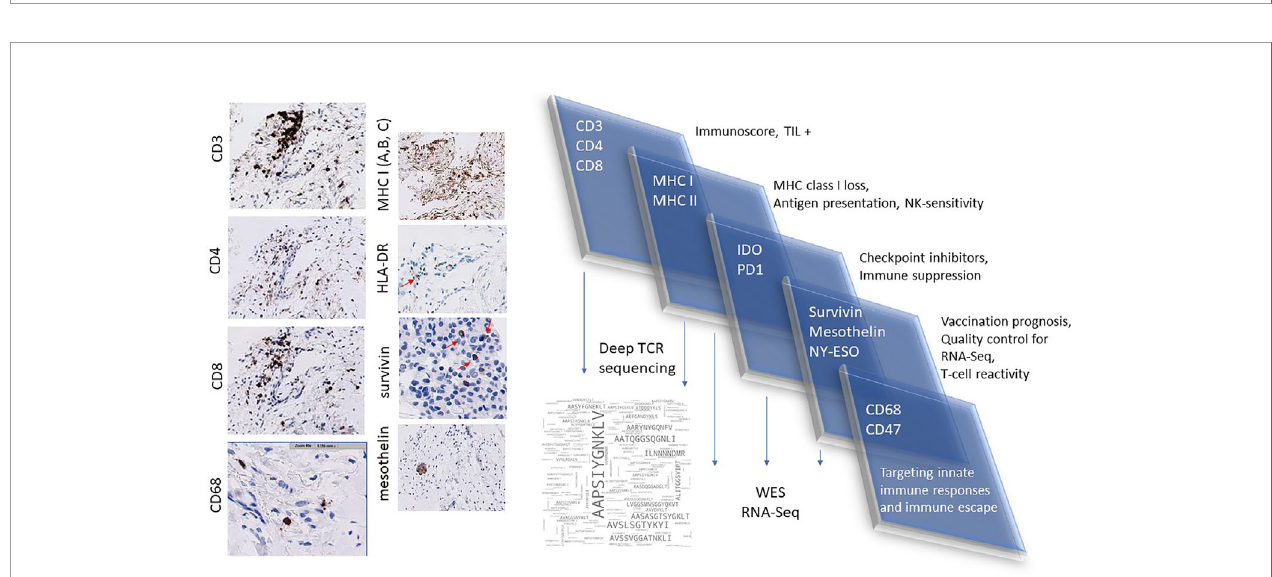
FIGURE 8 | Example of a standard immuno-histological analysis of a tumor sample at the Clinical Pathology Unit. Analysis of CD3 + , CD4 + and CD8 + T-cell in fi ltrates along with tumor-associated CD68 + macrophages. Testing for MHC class I (HLA-A, B and C) expression to screen whether transformed calls can be recognized by CD8 + T-cells, general MHC class I loss would not support vaccination strategies of adoptive T-cell therapy targeting TCR alpha/beta T-cells as the immune effector population. CD47, PD-1 and PDL-1 expression to gauge immune escape. Examination of commonly shared, non-mutant TAAs (NY-ESO-1, survivin, mesothelin) to identify T-cell responses in TIL and in corresponding PBMCs. Expression analysis of TAAs aids in quality control concerning RNA-Seq (of the corresponding gene coding for the TAA) and deep TCR analysis of T-cells reacting to